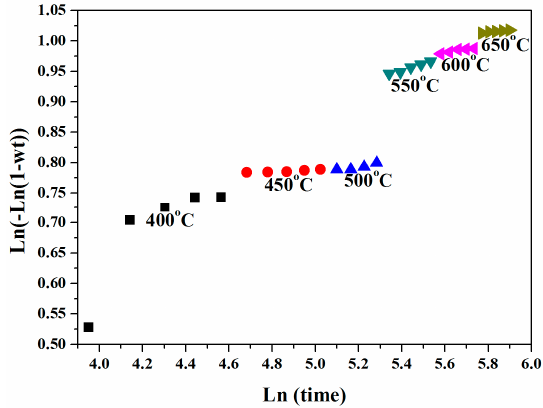
Figure 7. The Avrami plot used to determine the average temperature-dependent rate constant at 400, 450, 500, 550, 600, and 650 °C.